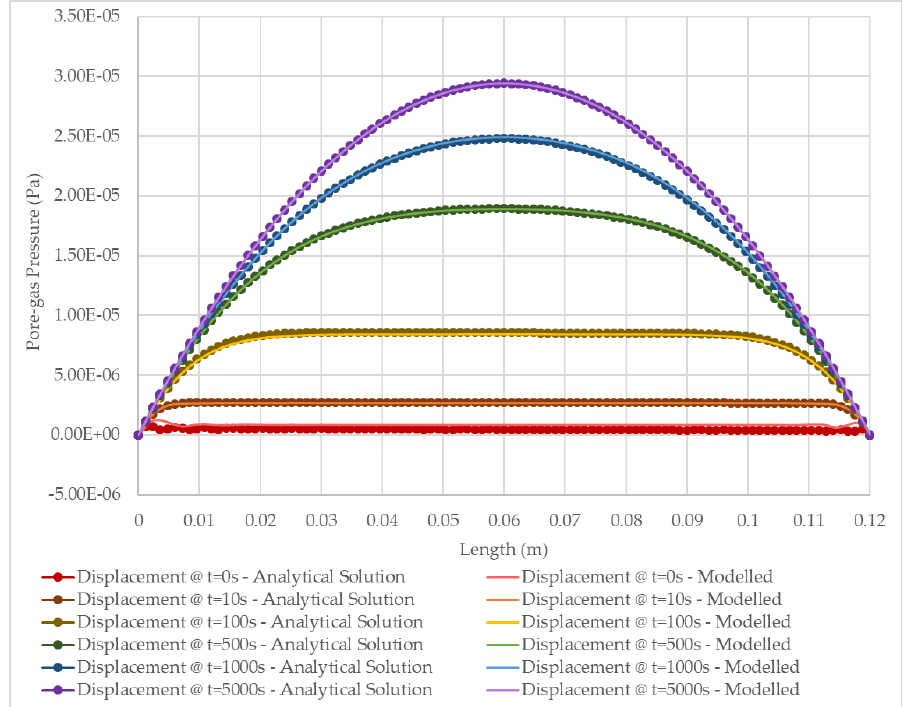
Figure 8. Verification study—1D transient solution results for displacement over the length of the specimen.